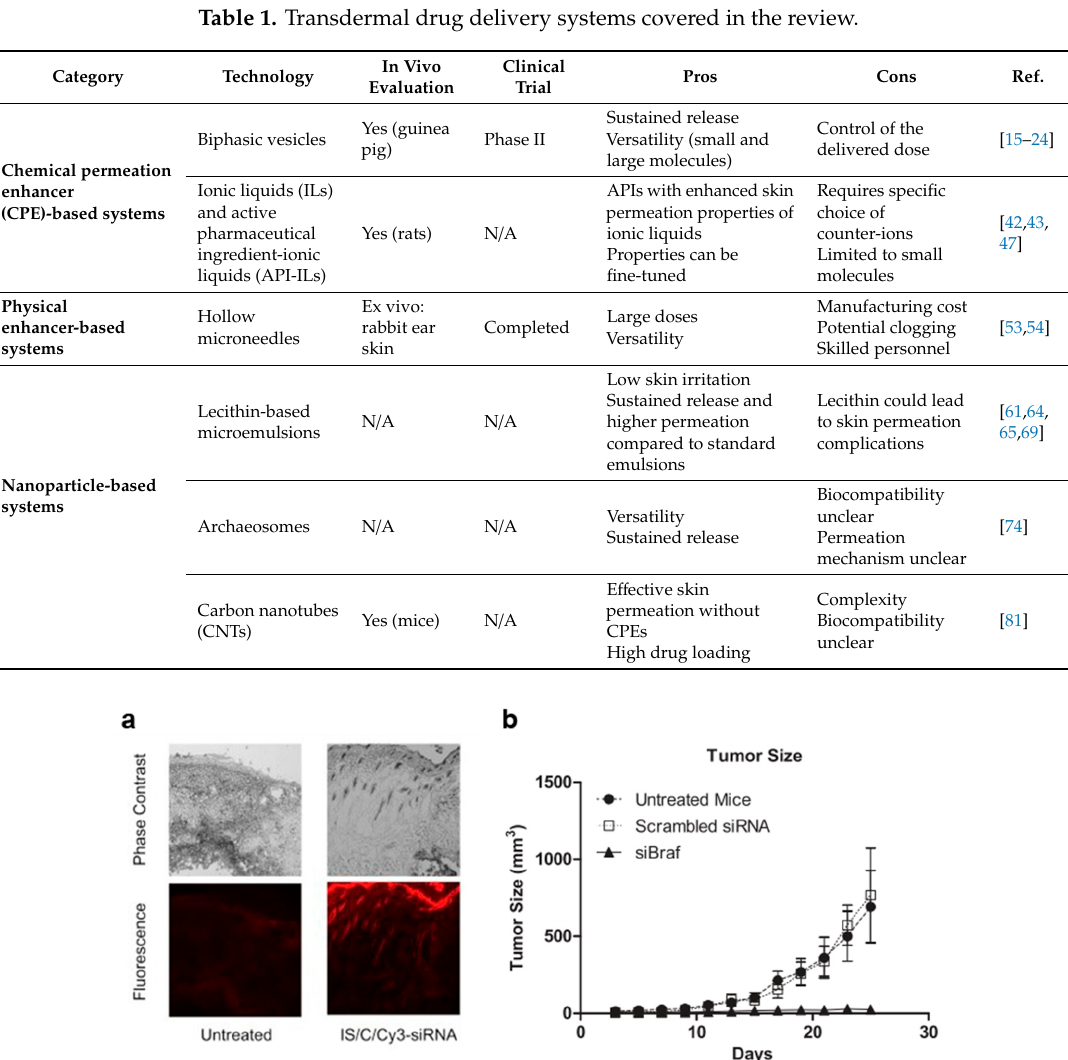
Figure 1. Carbon nanotube (CNT)-mediated delivery of siRNA in mice. ( a ) Representative images of tumor-bearing mouse skin treated with Cy3-labeled siRNA loaded CNTs; ( b ) tumor size evolution after topical administration of siRNA-loaded CNTs. Three days after the mice were injected with tumor cells, siRNA-loaded CNT solution was applied every 2 days for 25 days. Adapted with permission from [81]; published by Elsevier, Table 1. Transdermal drug delivery systems covered in the review.